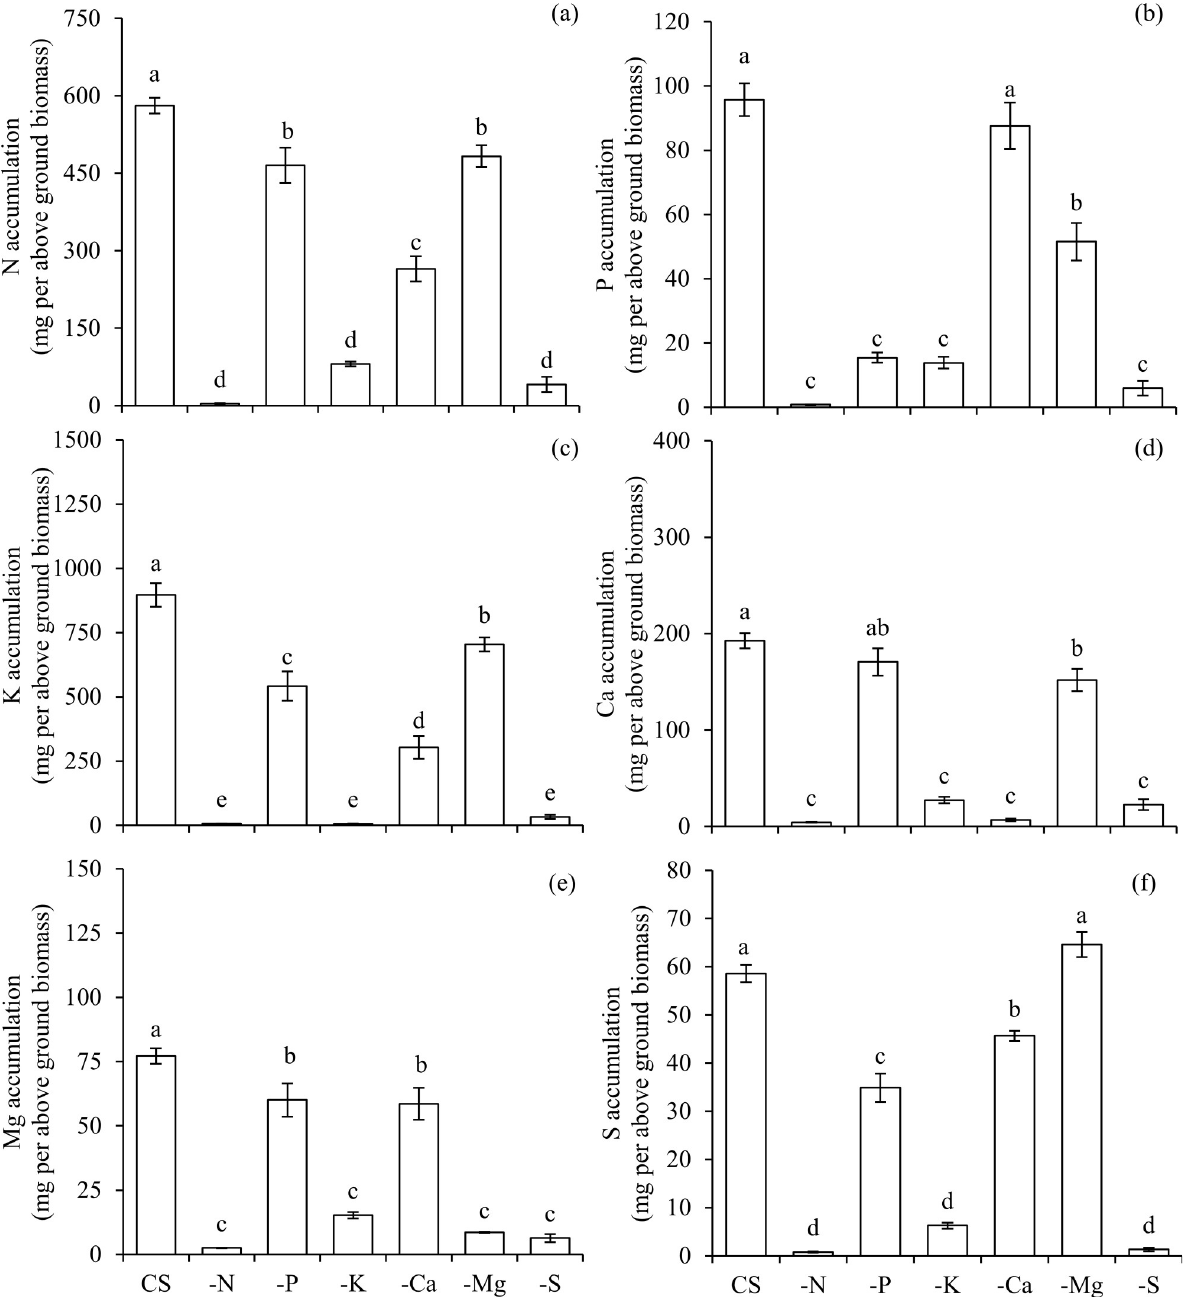
Fig 1. Accumulation of nitrogen (N) (a), phosphorus (P) (b), potassium (K) (c), calcium (Ca) (d), magnesium (Mg) (e), and sulphur (S) (f) in the above ground biomass of scarlet eggplants in complete solution (CS), and under the omission (-) of macronutrients ( − N, − P, − K, − Ca, − Mg, and − S). Means followed by the same letter in each bar did not differ from each other by the Tukey’s test (p � 0.05). Bars represent the standard error of the